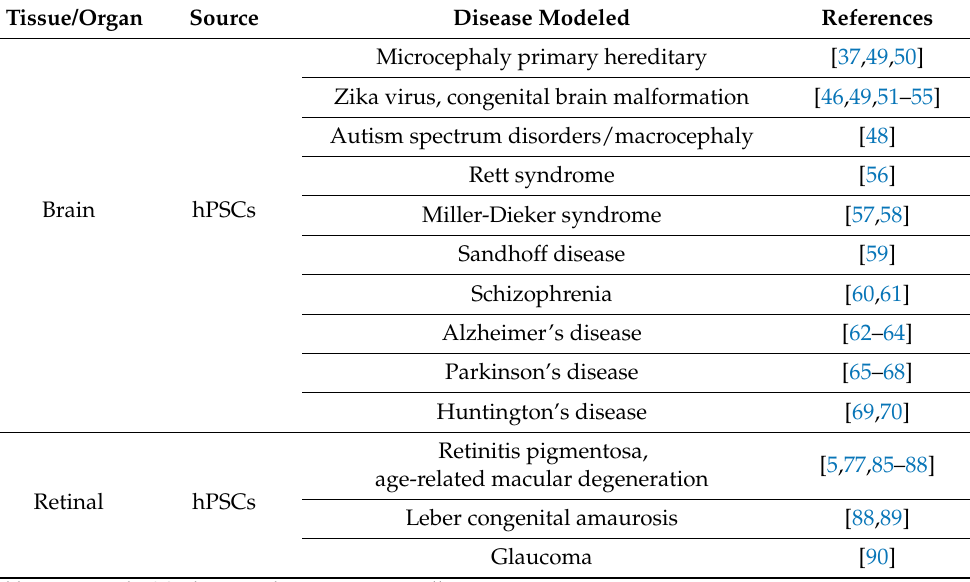
Table 1. Human pluripotent stem cells-derived brain and retinal organoids for modeling diseases.